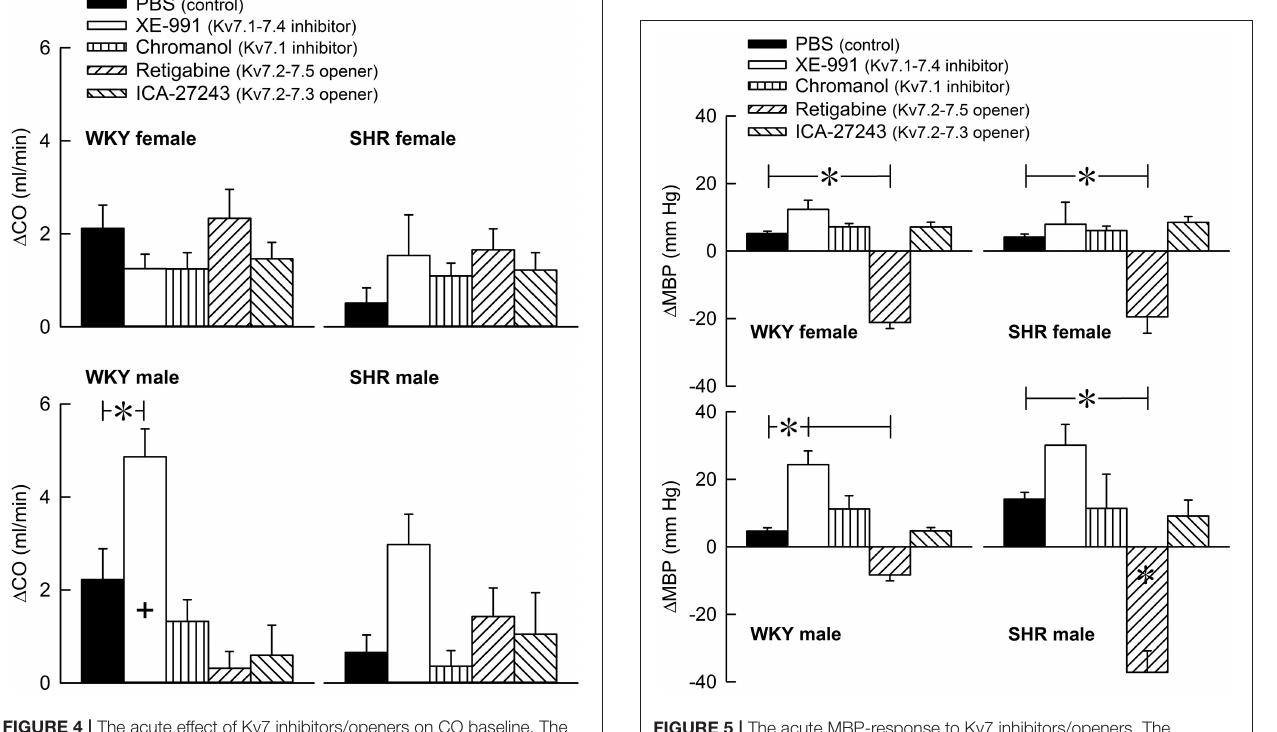
Frontiers in Physiology |